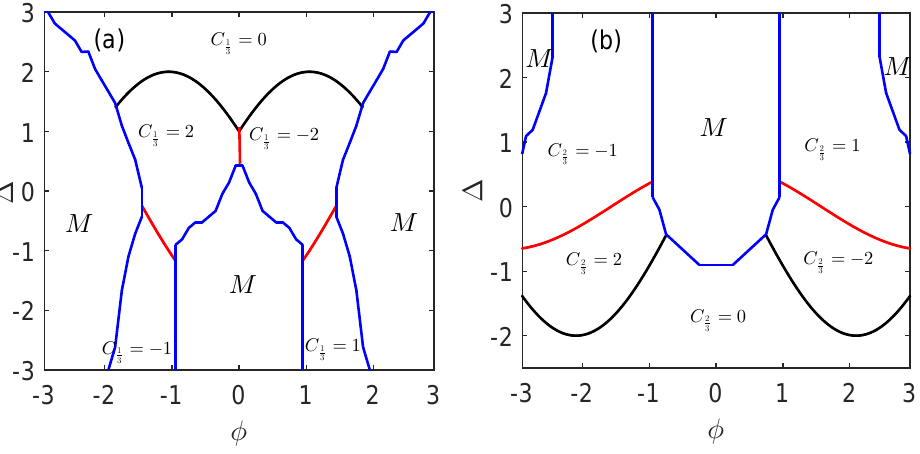
Figure 4. Two full phase diagrams with ( a ) 1/3 filling and ( b ) 2/3 filling, respectively. The blue solid lines and axes surround the metallic region ( M ), and the bulk insulating region consists of several topological regions. The black solid lines separate the topological nontrivial phase from the topological trivial phase, and the red solid lines distinguish the topological nontrivial phase with various C 1 and C 2 3 3